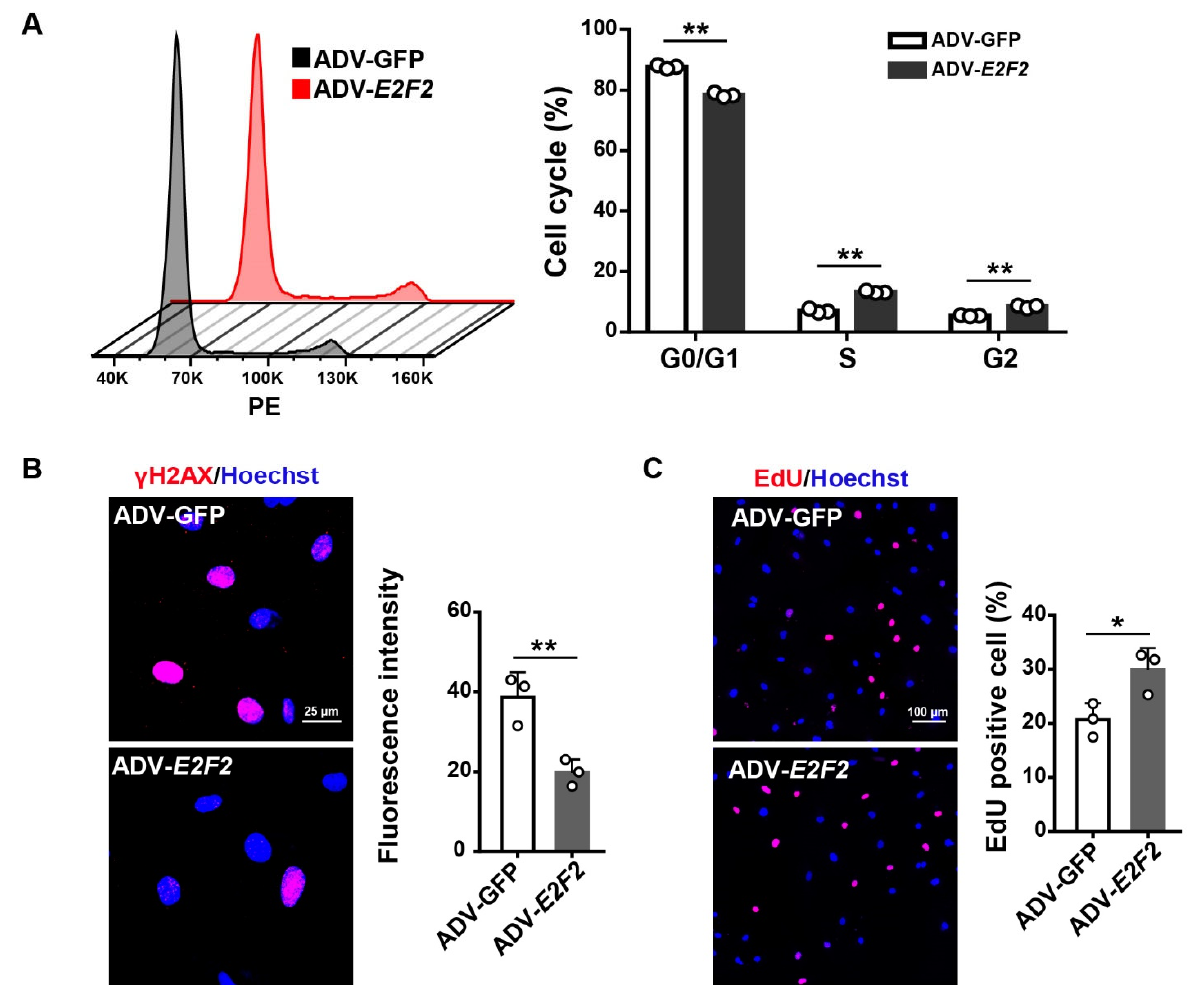
Figure 5. Restored endothelial cell function in E2F2 ‐ overexpressed HUVECs (PDL36). ( A ) Cell cycle analysis for HUVECs transfected with ADV ‐ E2F2 . Statistical analysis by two ‐ way ANOVA. ( B ) Immunofluorescent staining for the level of γ H2AX in E2F2 ‐ overexpressed HUVECs. Scale bar: 25 μ m. Student’s t test for the statistical comparison of mean fluorescent intensity. ( C ) EdU for cell proliferation in E2F2 ‐ overexpressed HUVECs. Scale bar: 100 μ m. Student’s t test for a comparison of the percentage of EdU ‐ positive cells. Data are means ± S.D. * p < 0.05, ** p < 0.01.